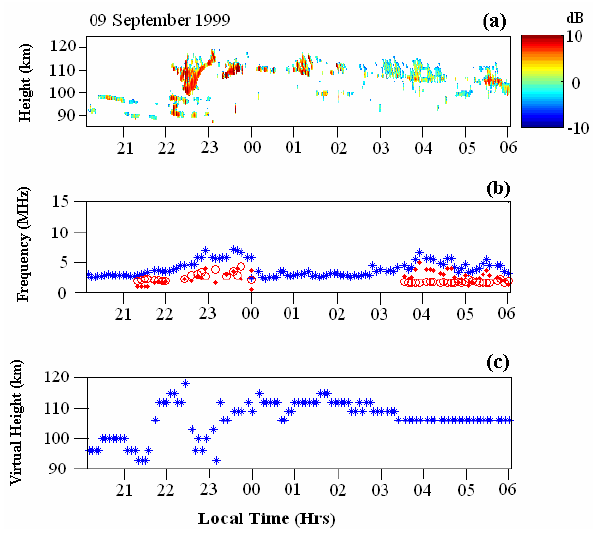
Fig. 2. Same as Fig. 1, but for nighttime on 9 August